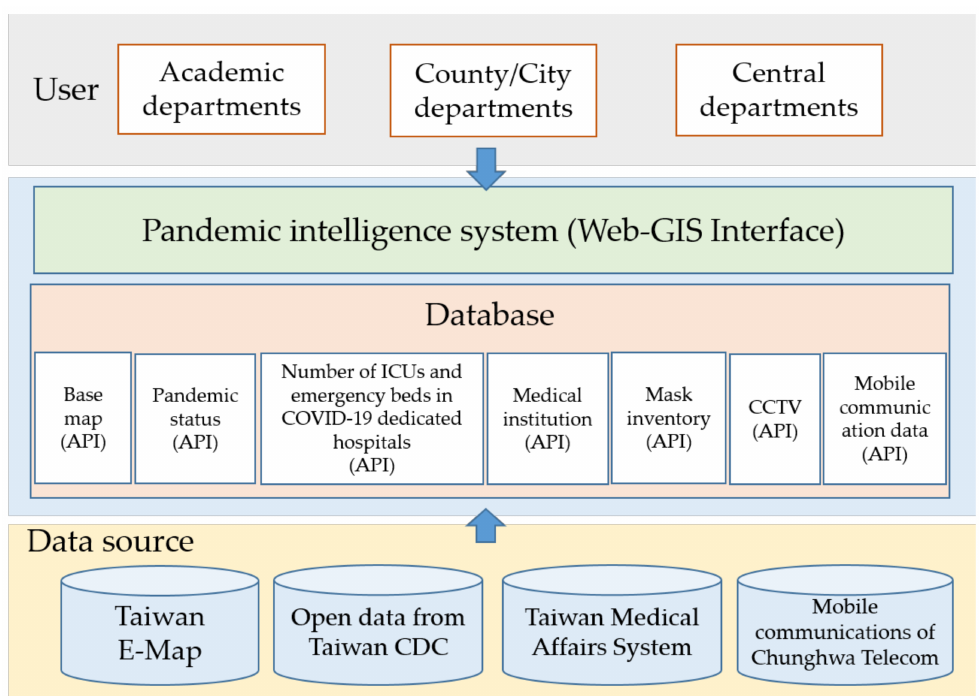
Figure 2. Structure of the pandemic intelligence